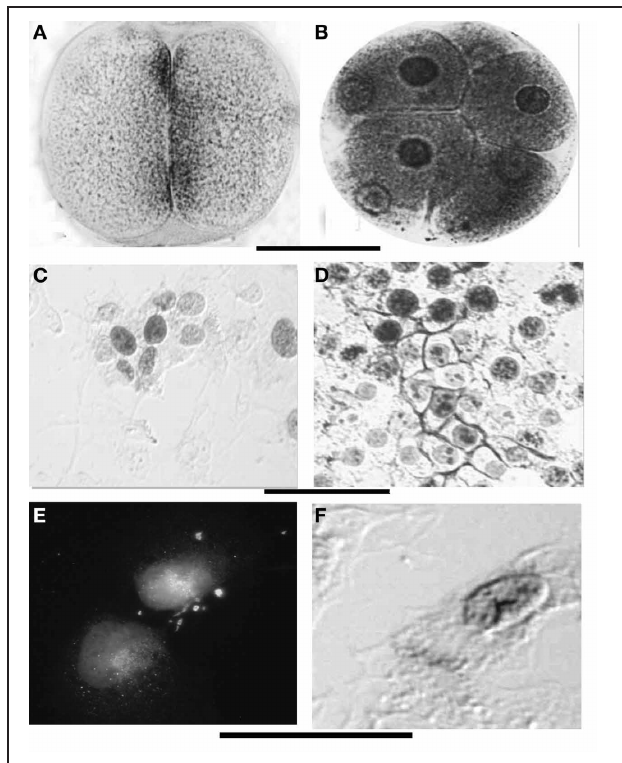
FIGURE 5 | (A,B) ChE localization at the membranes and perinuclear envelopes in sea urchin early embryos. (C,D) Show the similar aspect in cultured N-TERA2-D1 (teratocarcinoma cells), native (C) and activated by retinoic acid exposure (D) . In toto staining, Karnovsky and Roots (1964) with modified fixation; (E) Immunoreactivity to mammalian AChE antibody shows perinuclear localization of the protein, (D) AChE activity is present around the nuclei and at the periphery of the cells (arrow). Bars equal 50 μ m (A–D) and 12 μ m (E,F)